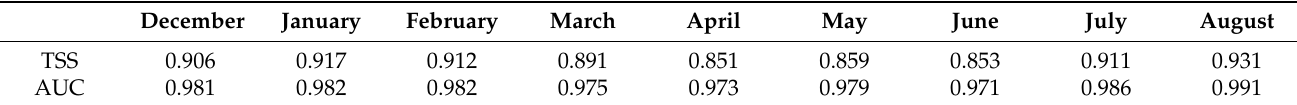
Table 4. TSS and AUC of the ensemble models. The AUC value is between 0.5 and 1, while the TSS value is between − 1 and